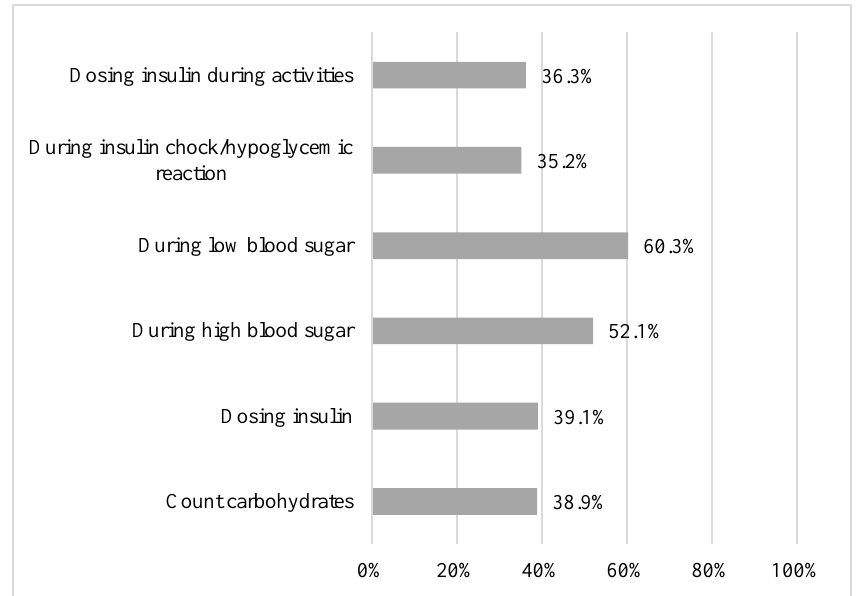
Figure 7. Proportion of participants prepared to help the student.